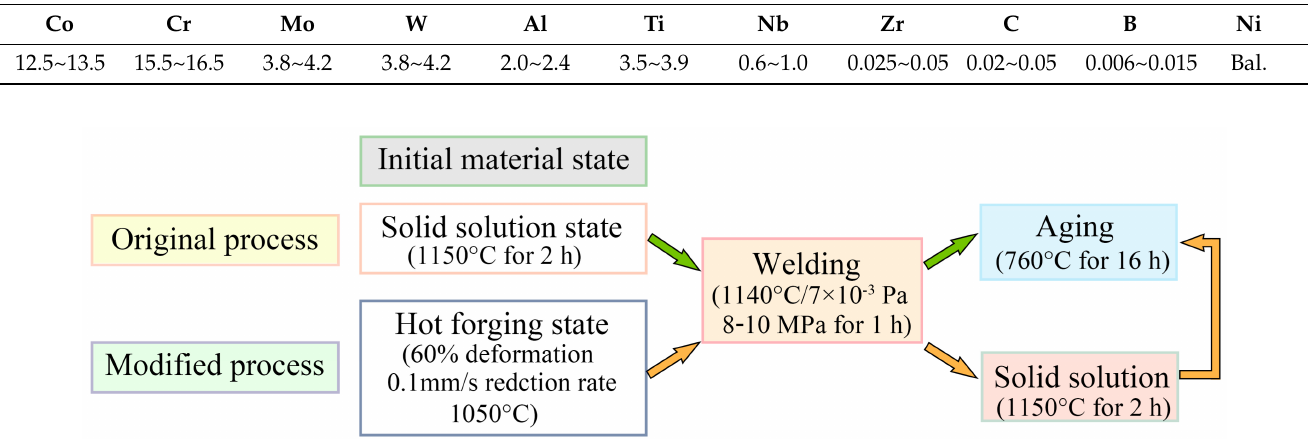
Table 1. Chemical composition of base material (BM), i.e., FGH 96 superalloy, in this study. Composition (wt.%)